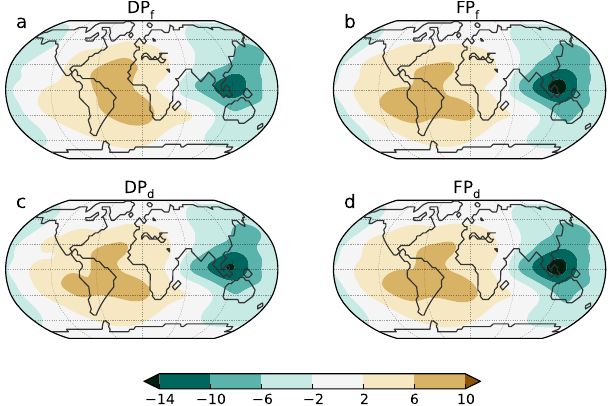
Figure 10. Velocity potential at 200hPa at the end of the desert world simulation (a) , the forest world simulation (b) , the DP d sim- ulation (c) , and the FP d simulation (d) . The average over the last 30 years of the respective simulation is considered. The DP d sim- ulation and the FP d simulation start from the desert world simula- tion and the forest world simulation, respectively. Brown colours indicate to a positive velocity potential, upper-air convergence, and subsidence. Green colours indicate to a negative velocity potential, upper-air divergence, and